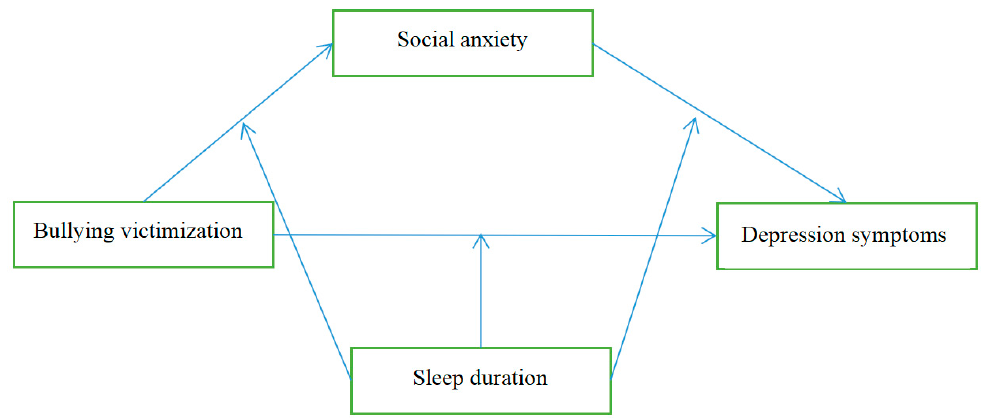
Figure 1. Logical frame